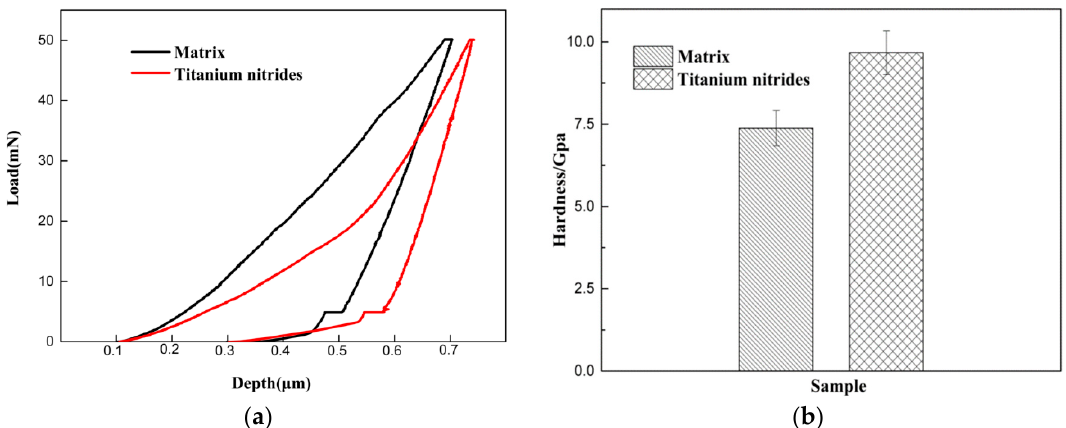
Figure 8. ( a ) Nano-indentation load-depth curves for precipitations (TiN) and matrix of 30ZrN, and ( b ) hardness of precipitations (TiN) and matrix of 30ZrN.